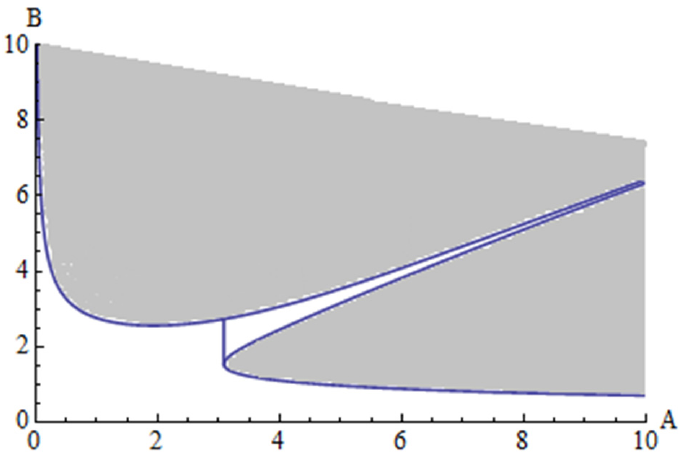
Figure 4. Stability domain for case 1 (shadow area): a 1 = 2, a 2 = 2.5, e 1 = 3, e 2 = 3.3.